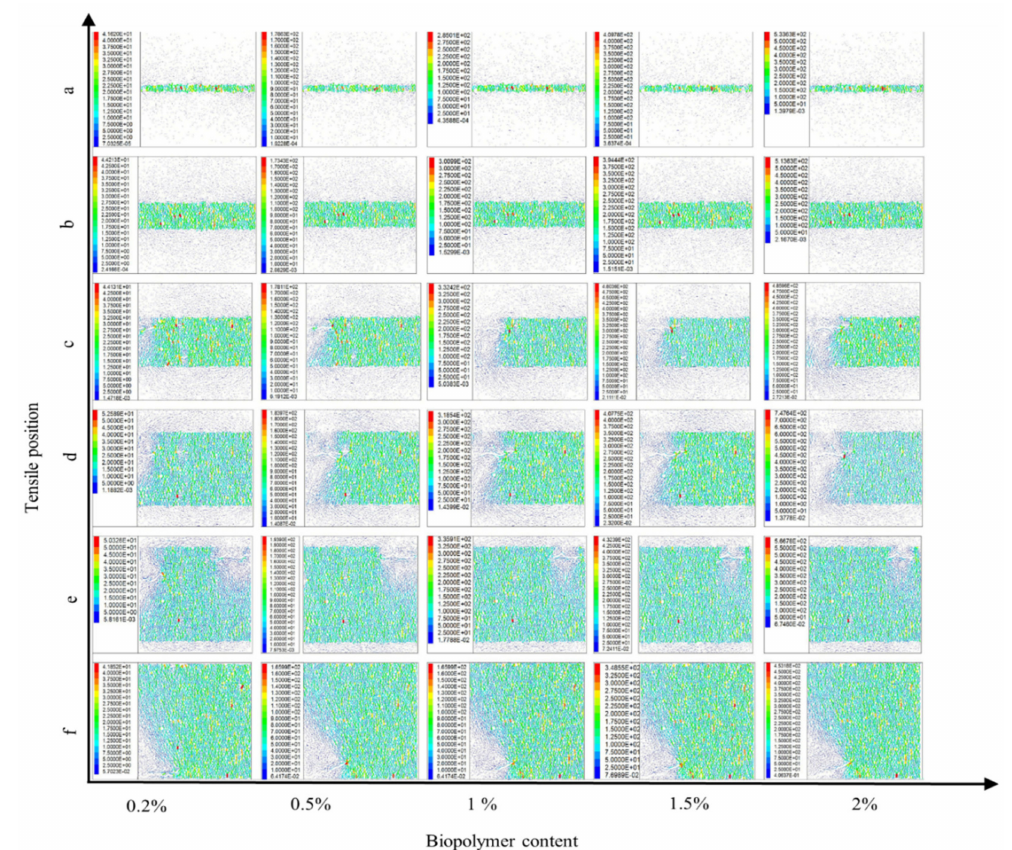
Figure 8. Di ff erent biopolymer treated sample force contour under di ff erent tensile